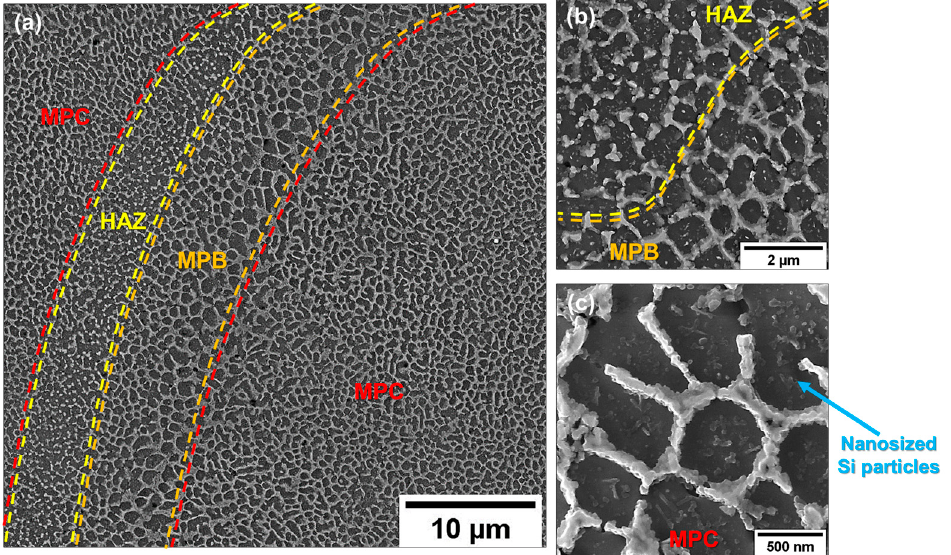
Figure 5. T5 microstructure before high-temperature tests observed on the transversal section of fatigue specimens. Intersection area between adjacent scan tracks ( a ). Detail of the MPB and HAZ on border area ( b ) and MPC ( c ).